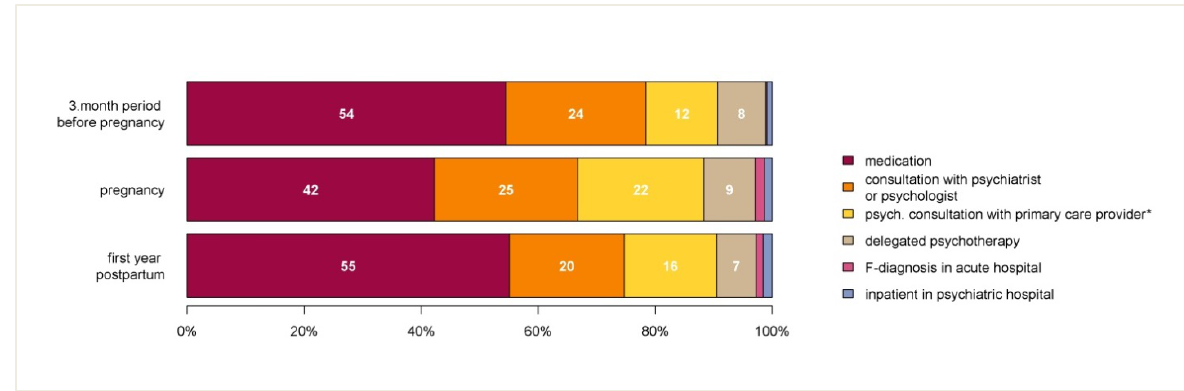
Figure 2: Proportions of medication and five types of consultation by period. For women who gave birth in Switzerland 2012 or 2013 (n = 15 104), Helsana health insurance data. *Services summarised here also include a minor fraction provided by gynaecologists and other care providers.